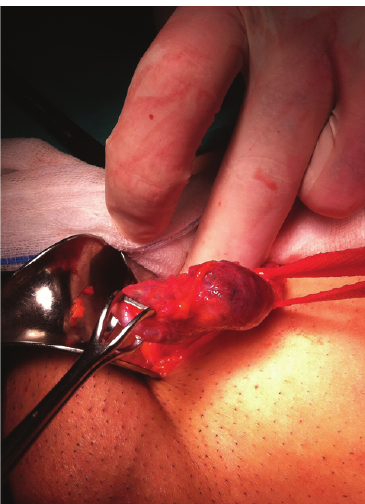
Figure 1: Intraoperative photograph of the mesothelial cyst origi- nating from the round ligament.